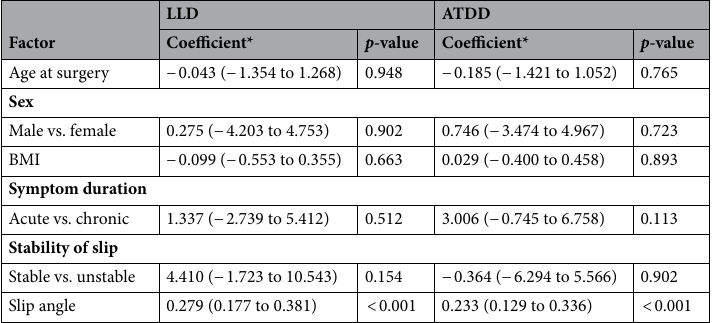
Table 2. Univariable linear regression analysis of LLD and ATDD in all cohorts. CI confidence interval, LLD leg length discrepancy, ATDD articulotrochanteric distance difference. *Values are given as coefficients with the 95% CI in parentheses.